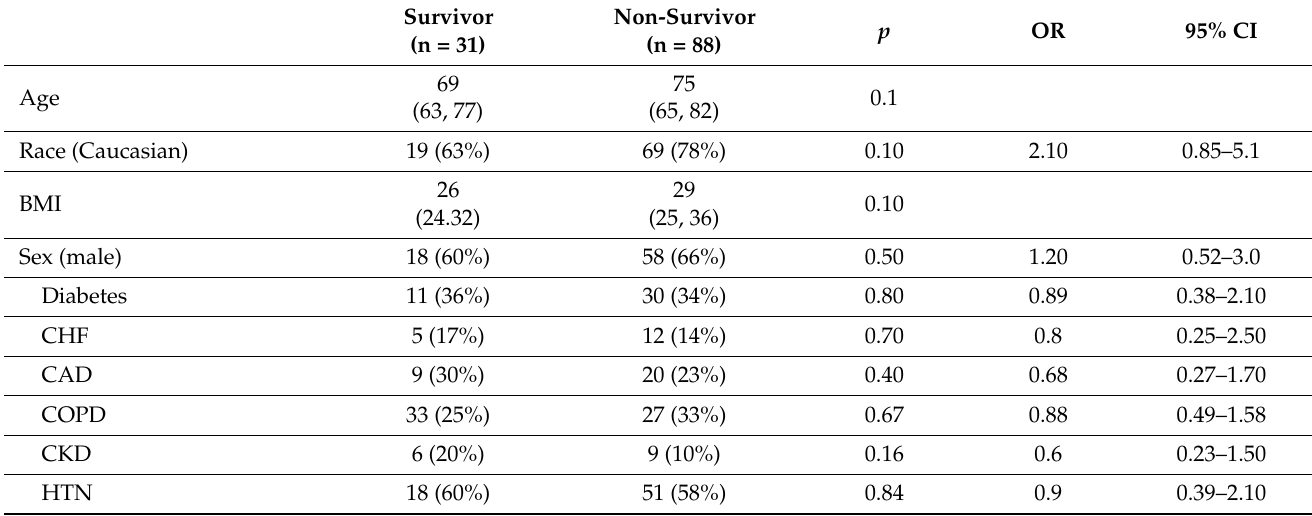
Table 6. Risk factors for mortality among COVID-19 ICU patients with